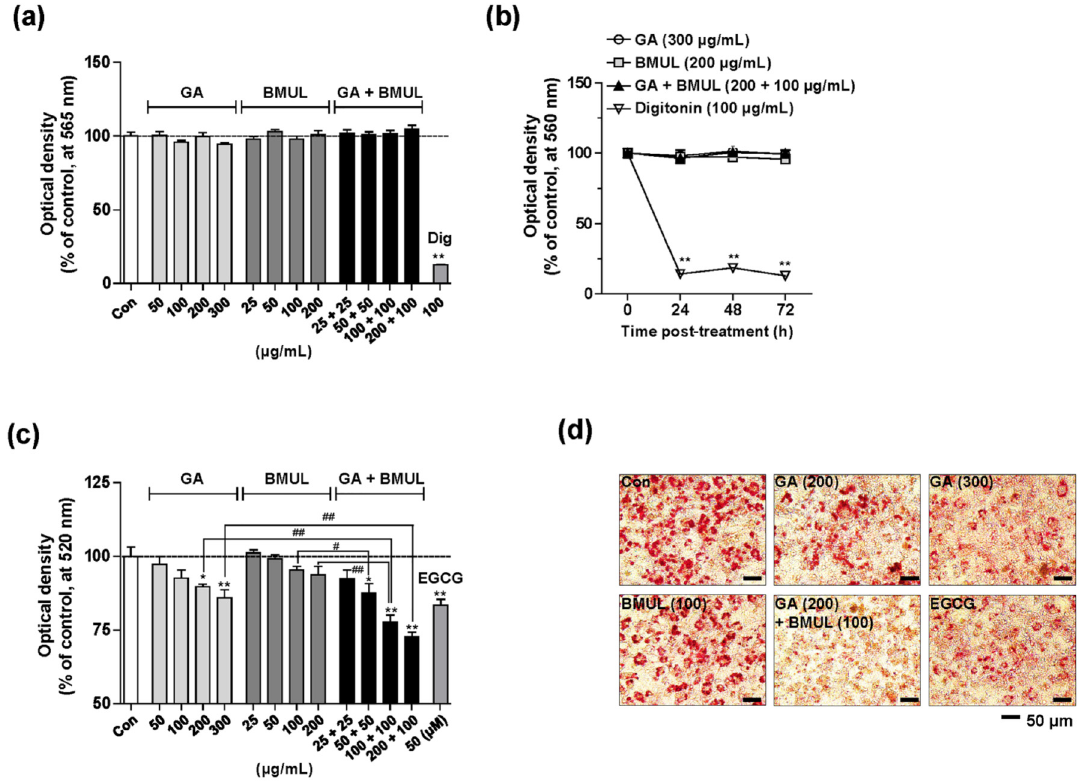
Figure 1. Combined treatment of Garcinia cambogia extract (GA) and bioconverted mulberry leaf extract by Pectinex (BMUL) has synergistic effect on inhibition of lipid accumulation in 3T3-L1 cells without cytotoxicity. Cytotoxicity of GA, BMUL, and GA and BMUL mixture (GA + BMUL) in 3T3-L1 preadipocytes. ( a ) Cells were treated with each of the compounds at the indicated concentrations for 24 h, and cell viability was assessed by MTT assay. Digitonin (Dig, 100 μ g/mL) was used as positive control for cytotoxicity. ( b ) Cells were treated with the highest concentrations of GA (300 μ g/mL), BMUL (200 μ g/mL), GA + BMUL (200 + 100 μ g/mL), and Dig for 24, 48, and 72 h. ( c ) Effect of mono or combined treatment of GA and BMUL on lipid accumulation in 3T3-L1 adipocytes.